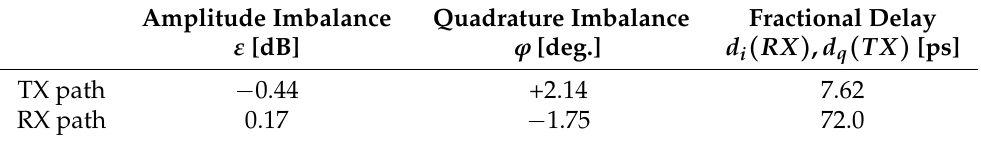
Table 4. Measured frequency-independent I/Q compensation parameters at 62 GHz.